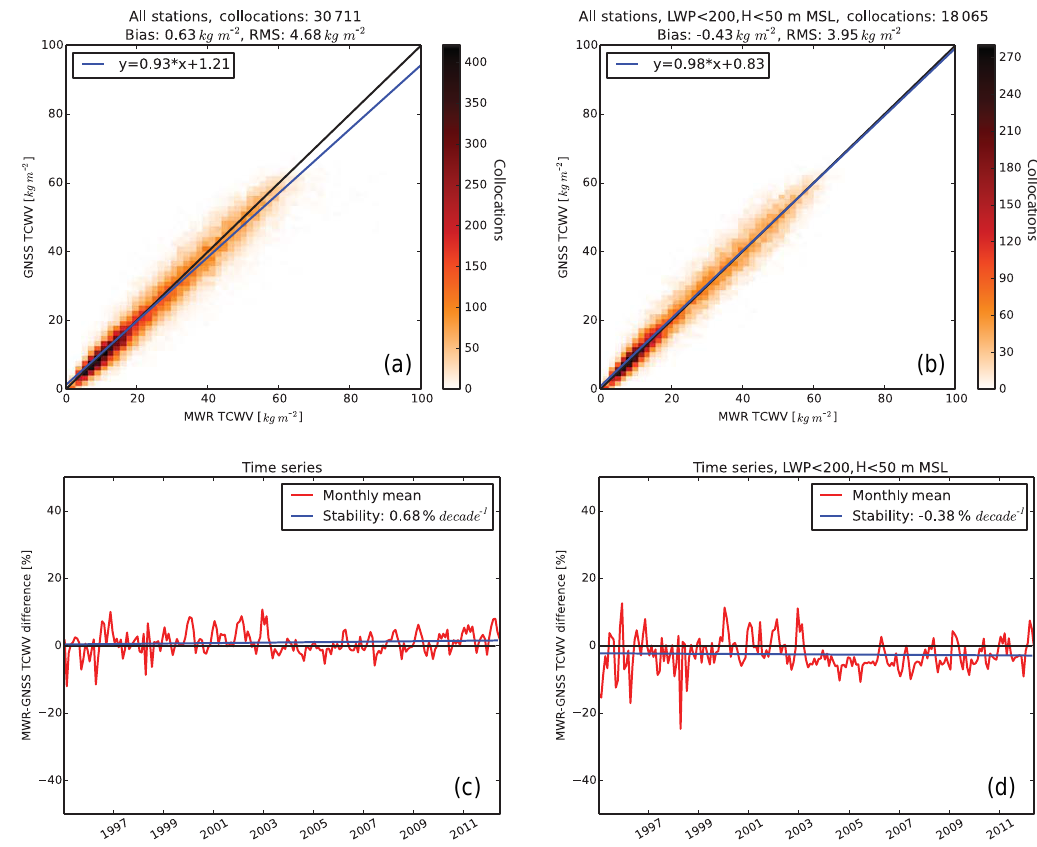
Figure 5. Comparison of GNSS and MWR-derived TCWV. (a) and (c) show comparisons for all collocations. (b) and (d) show comparisons for a subset of collocations where (1) MWR-retrieved LWP was smaller than 200gm − 2 and (2) the GNSS station height was below 50m above MSL. (a) and (b) show data density plots. (c) and (d) show time series of monthly-mean differences between MWR and GNSS for the entire dataset. The blue lines give linear fits to the